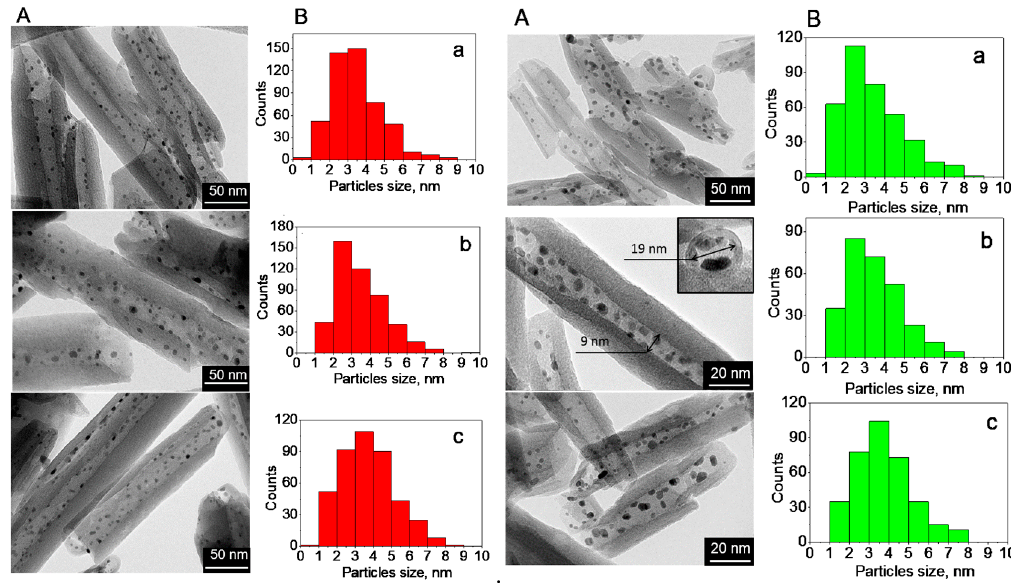
Figure 1. TEM image ( A ) and particle size distribution ( B ) of fresh pristine halloysite (HNT)@Ru-1 (a), HNT@Ru-2 (b), and HNT@Ru-3 (c) (left), and spent HNT@Ru-1 (a), HNT@Ru-2 (b), and HNT@Ru-3 (c) (right). Physico-chemical characteristics of Ru-loaded halloysite